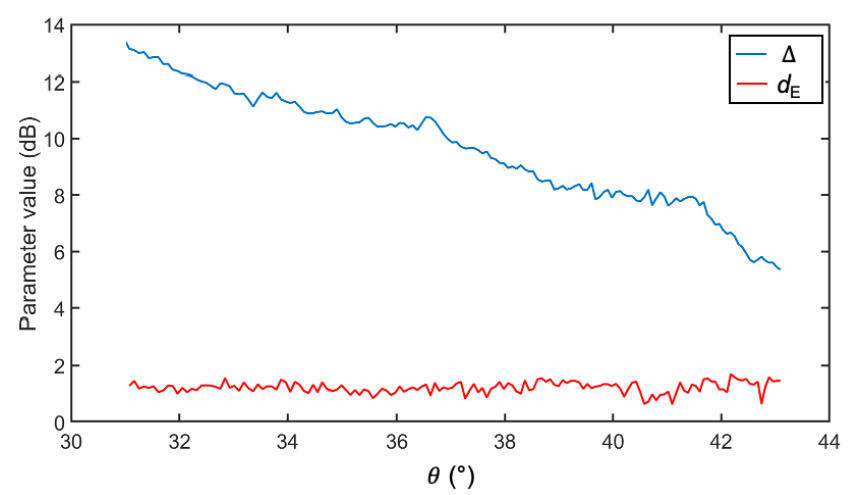
Figure 5. Behavior of the ∆ and d E parameters versus the incidence angle θ evaluated along with the dashed white range transect highlighted in Figure